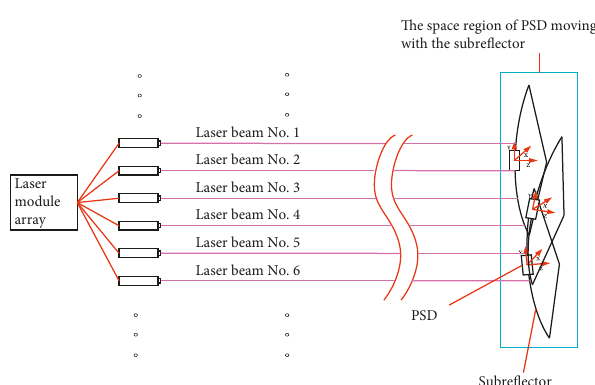
Figure 4: Schematic diagram of the motion space of the laser array and detector.